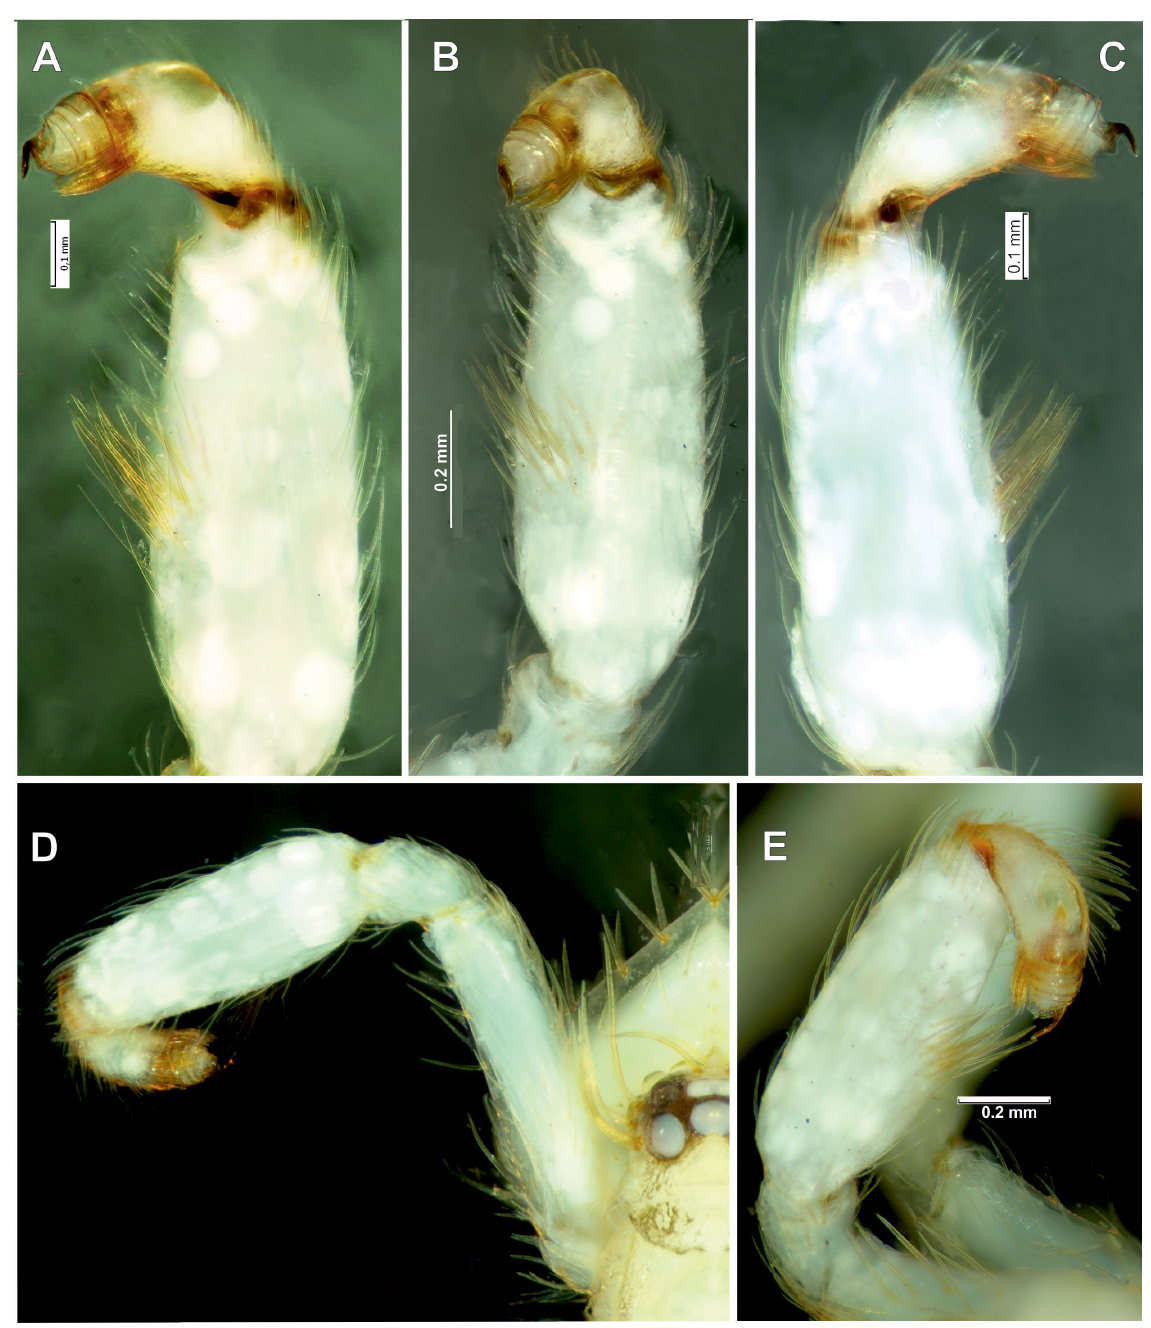
Fig. 20. Palp of Zaitunia logunovi sp. nov., paratype, ♂. A – C . terminal part, retrolateral, ventro- retrolateral and prolateral. D–E . entire palp, prolateral and proventral. Scale bars: a, C = 0.1 mm; B, e = 0.2